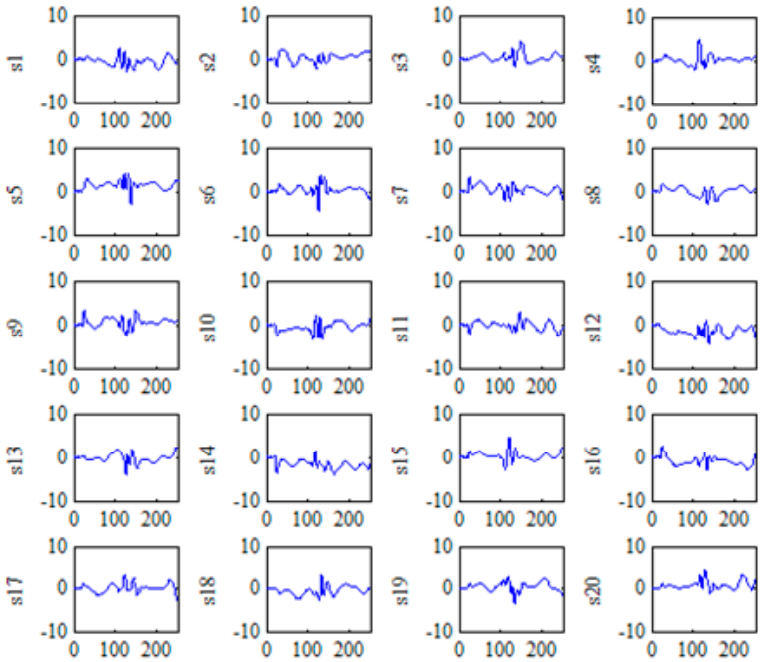
Figure 5. Feature subspace obtained through kernel-independent component analysis (KICA). ( s1 – s20 ) are 20 independent base signals, x -axis represents sample points of the ECG signal and y -axis is the amplitude.